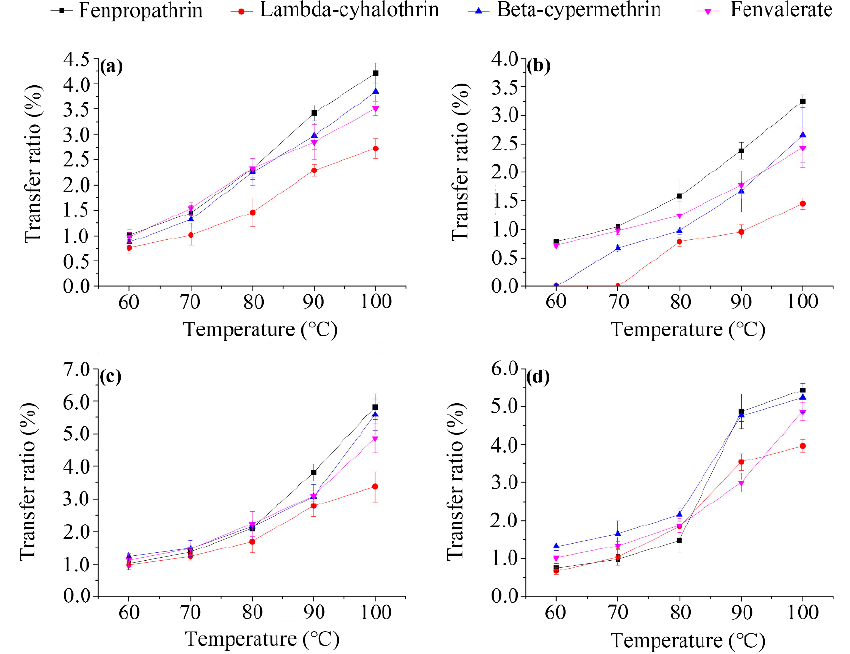
Figure 1. Effect of water temperature on the transfer ratio (defined as the ratio of the amounts of residues in tea and water) of the four pyrethroid residues from wolfberry ( a ); licorice ( b ); honeysuckle ( c ); and chrysanthemum ( d ) tea leaves to infusion.